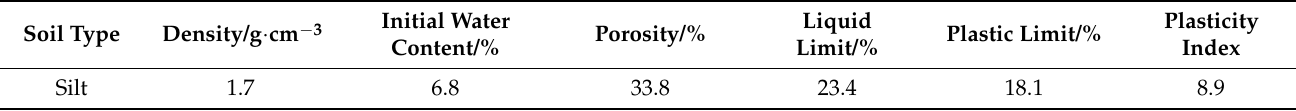
Table 1. Basic physical properties of soil samples.